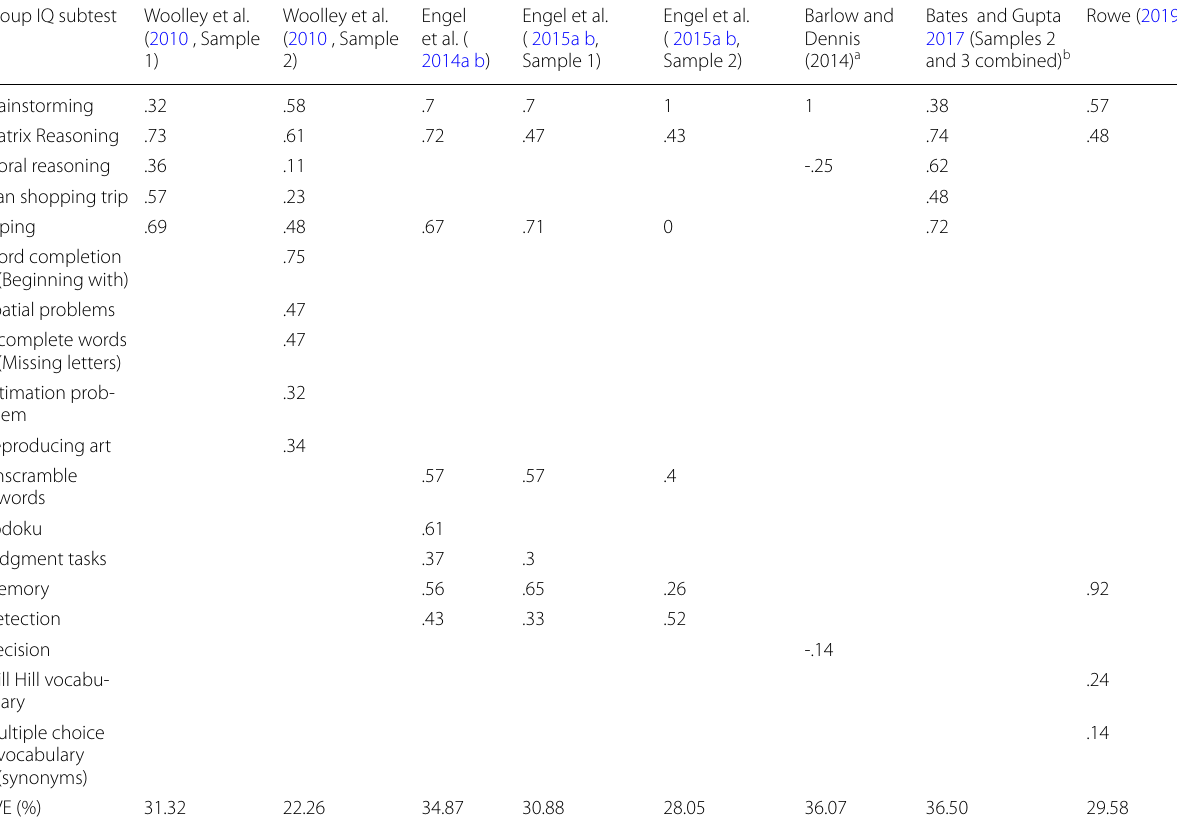
Table 2 Standardized loadings and average variance extracted across 8